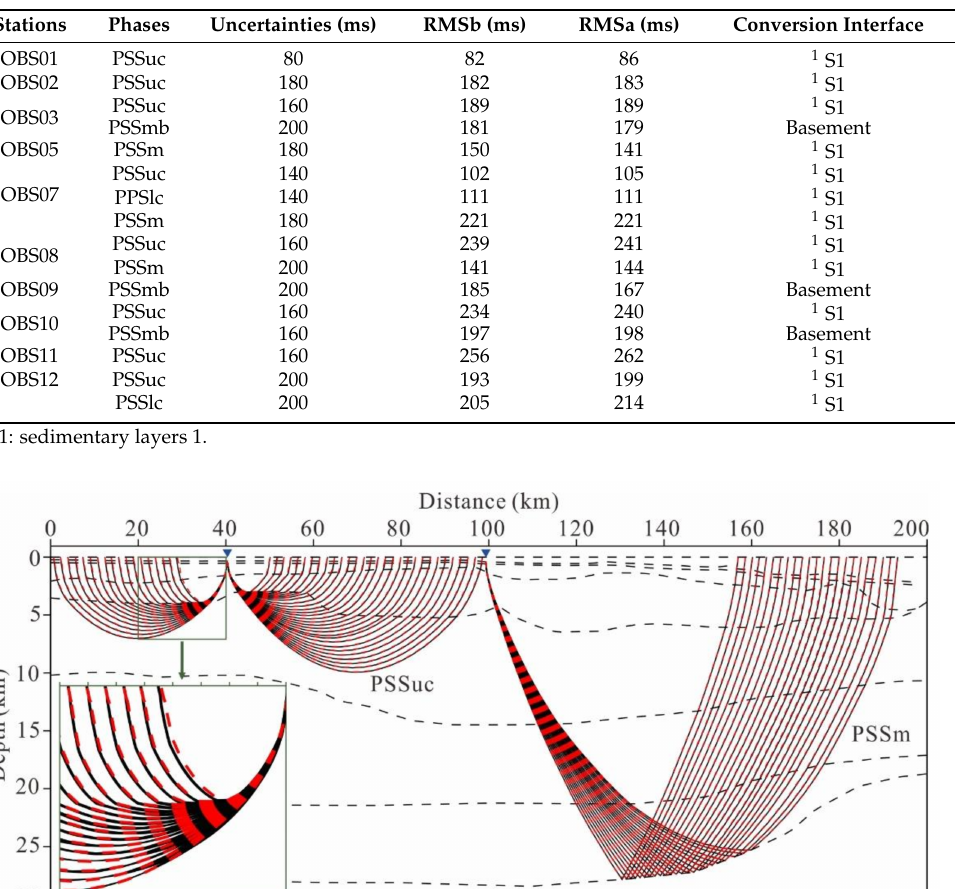
Table 1. The total root–mean–square travel-time residuals before (RMS b ) and after (RMS a ) travel- times correction, picking uncertainties, conversion interface, for PSS mode arrival phases.